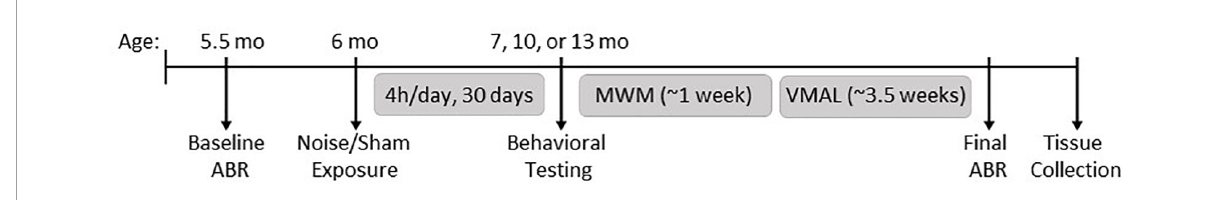
FIGURE1 Experimental timeline. Rats underwent a baseline hearing test measured using the auditory brainstem response (ABR) at 5.5 months of age, followed by noise or sham exposure at 6 months of age (100 dB SPL; 4 h/day, 30 days). Behavioral testing began at 7 months (immediately following noise exposure), 10 or 13 months of age, and included the Morris water maze (MWM) and visuomotor associative learning tasks (VMAL). Upon completion of behavioral testing, a final hearing test was performed, and rats were then sacrificed for tissue collection.